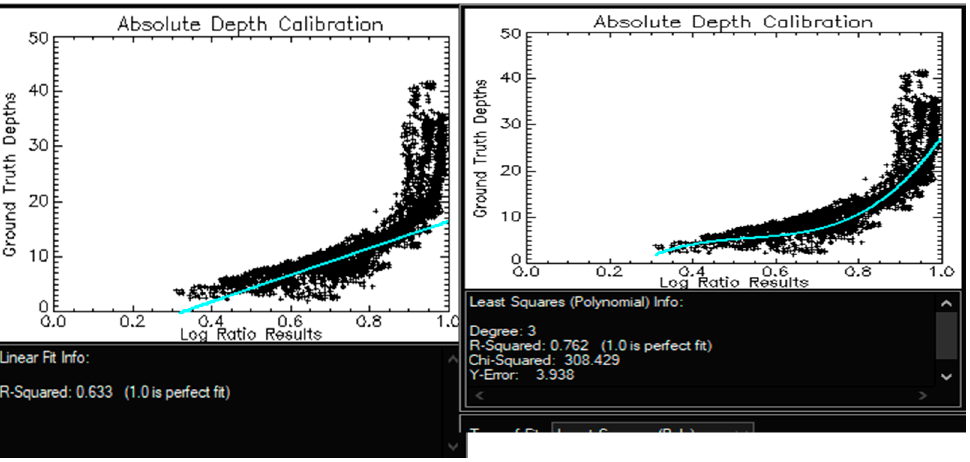
Figure A10. From 29 January 2016.